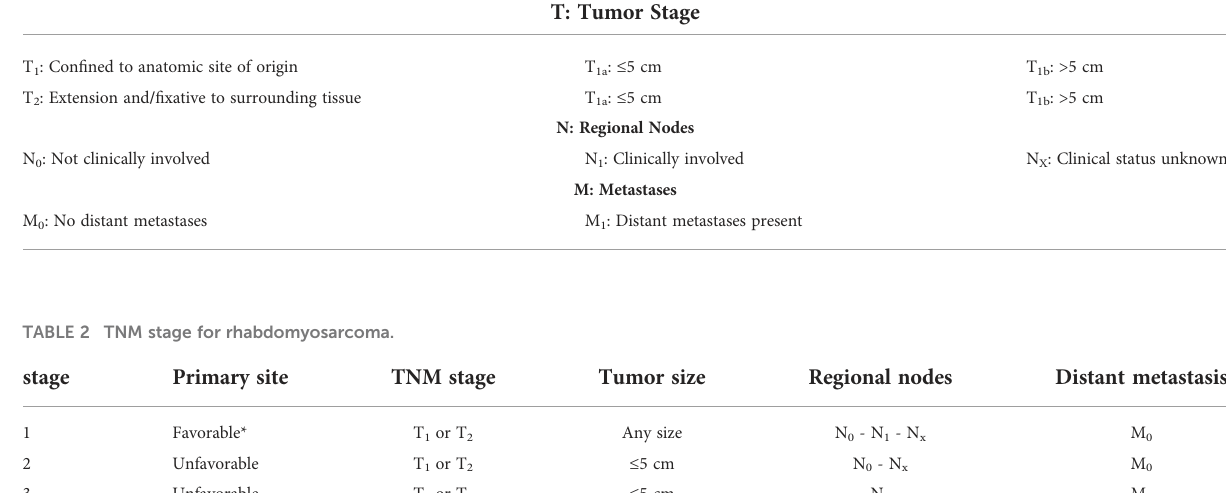
TABLE 1 TNM classi fi cation for